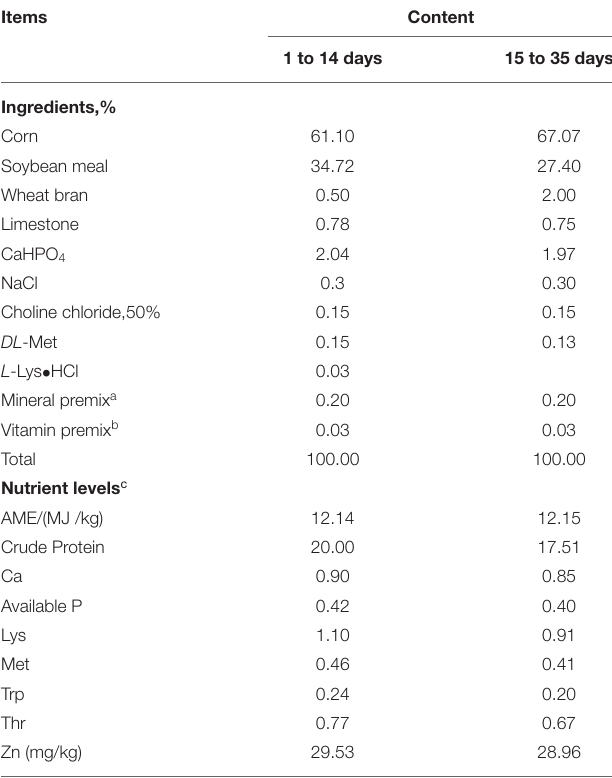
TABLE 1 | Composition and nutrient levels of basal diets (%, air-dry basis).